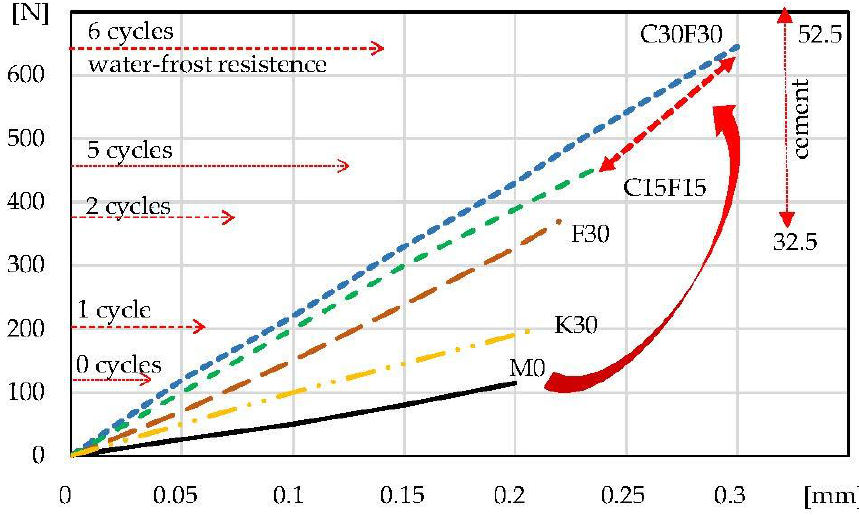
Figure 8. Load–displacement of crosshead curves: lime mortars during tensile bending f tb with water–frost resistance results.